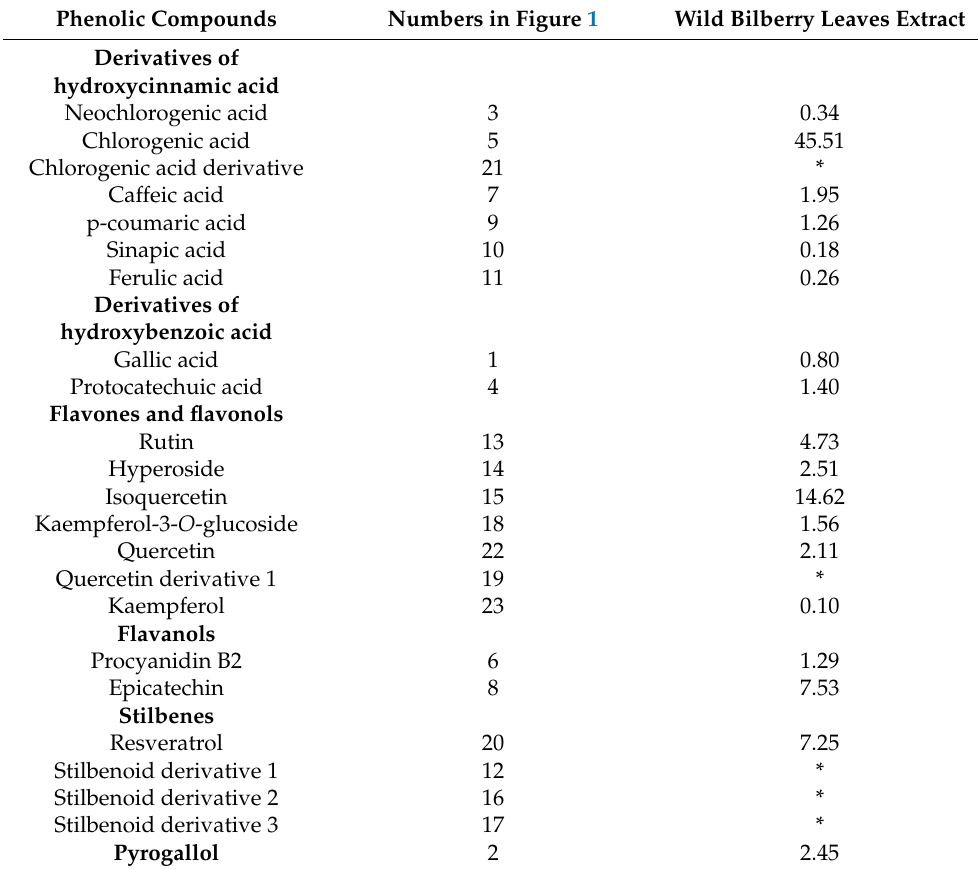
Figure 1. HPLC chromatograms of investigated extract of wild bilberry leaves and phenolic com- pound identified at 325 nm. Table 3. Content of phenolic compounds determined by HPLC in the investigated wild bilberry leaves extract